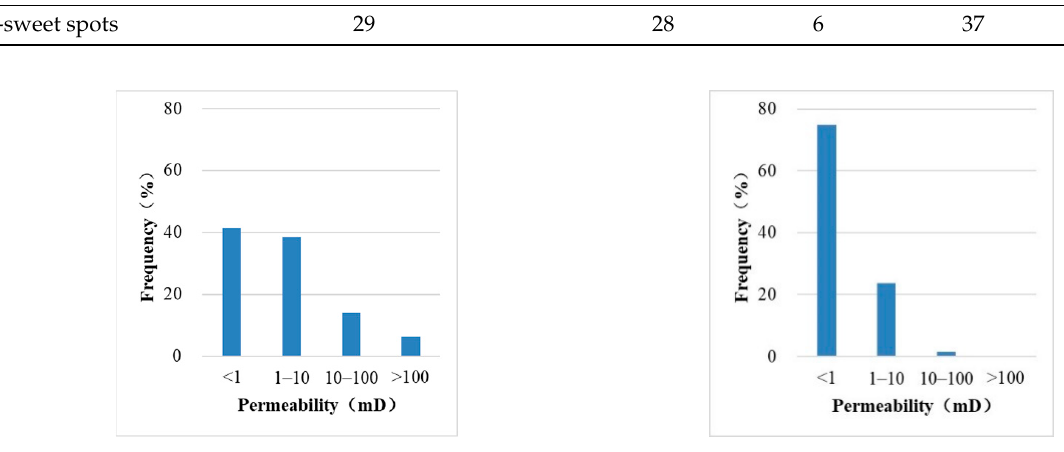
Figure 2. Histogram of petrophysical property distribution in the study area. Table 1. Data of average relative content of clay minerals in the X gas field.